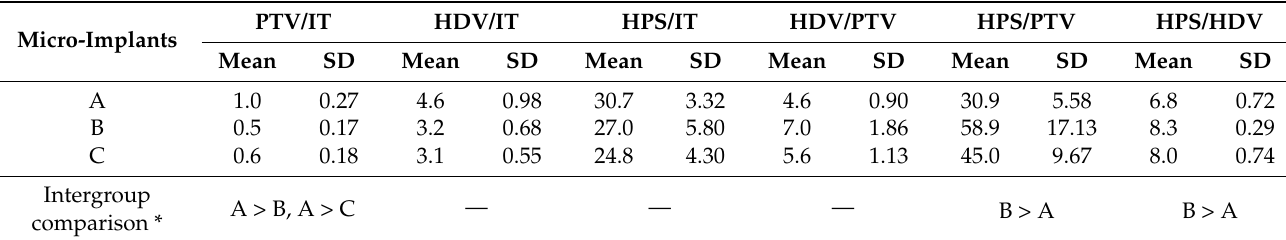
Table 3. Mechanical strength ratios (PTV/IT, HDV/IT, HPS/IT, HDV/PTV, HPS/PTV, HPS/HDV) analysis of microimplants in the Kruskal-Wallis H-test with a Dunn’s post hoc comparison test. Micro-Implants